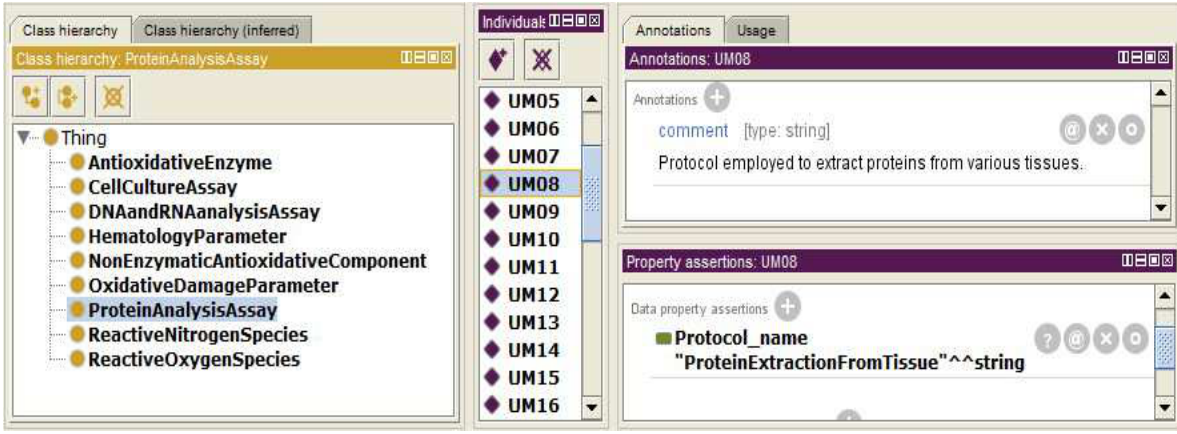
Figure 5. Separate file with